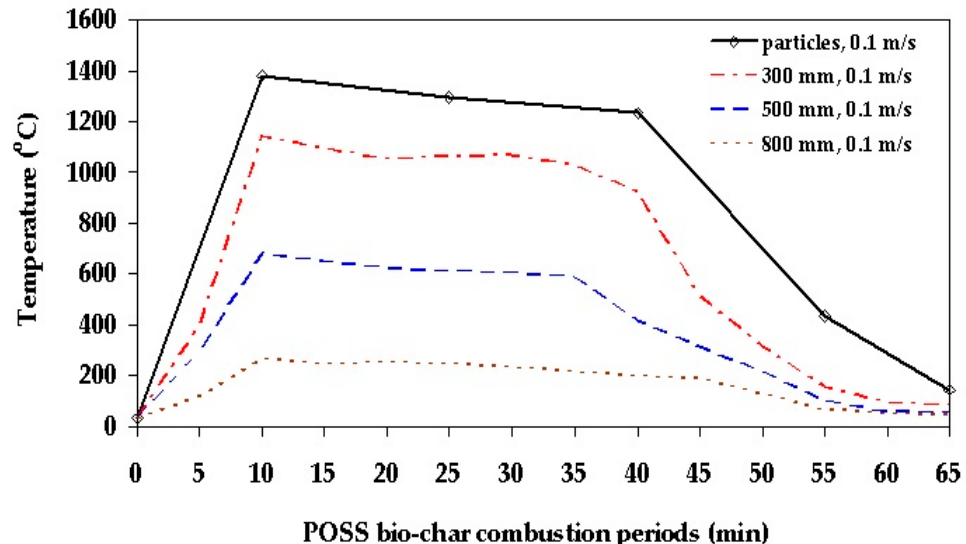
Figure 3. The temperature under the condition of 0.1 m/s clean air speed and 15% d.b. of POSS bio-char moisture content for the particles and different distances above the fire base.